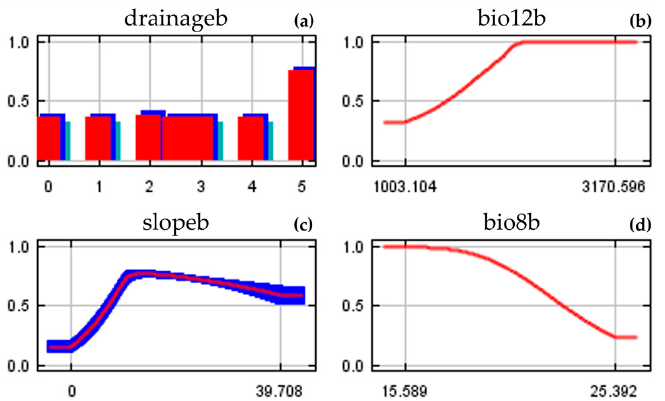
Figure A2. The response curve of A. pictum ’s dominant environmental factors. ( a ) indicates that of drainage; ( b ) indicates that of bio12; ( c ) indicates that of slope; ( d ) indicates that of bio8. Red curves show the mean response of the 10 replicate Maxent runs and blue margins(two shades for categorical variables) indicate ±1 standard deviation.